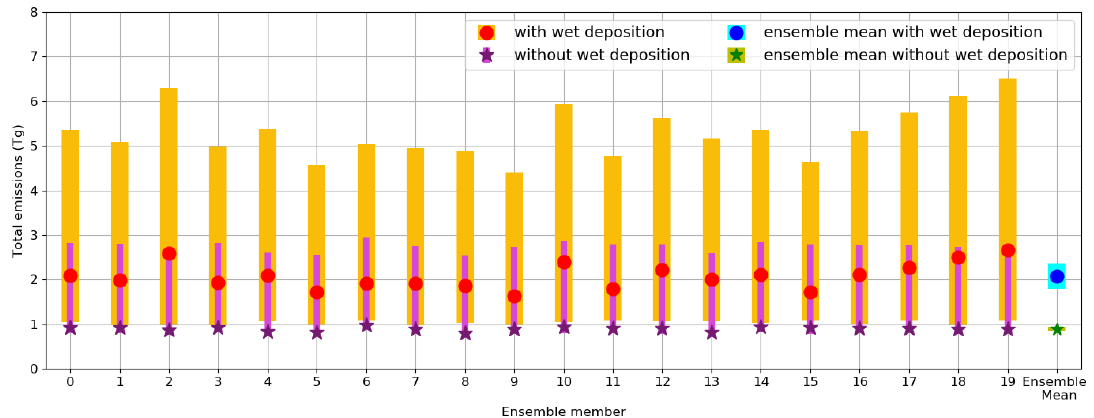
Figure 6. Total ash emitted during the Grímsvötn eruption for each ensemble member in the EPS ensemble determined using InTEM. Red circles and orange bars indicate the peak in the posterior distribution and range ( ± one standard deviation) of the total ash emitted for simulations that include wet deposition. Purple stars and lilac bars indicate the peak of the posterior distribution and range of the total ash emitted for simulations that do not include wet deposition. The final column shows the mean and standard deviation for the ensemble emissions with (blue circle and cyan bar) and without wet deposition (green star and light green